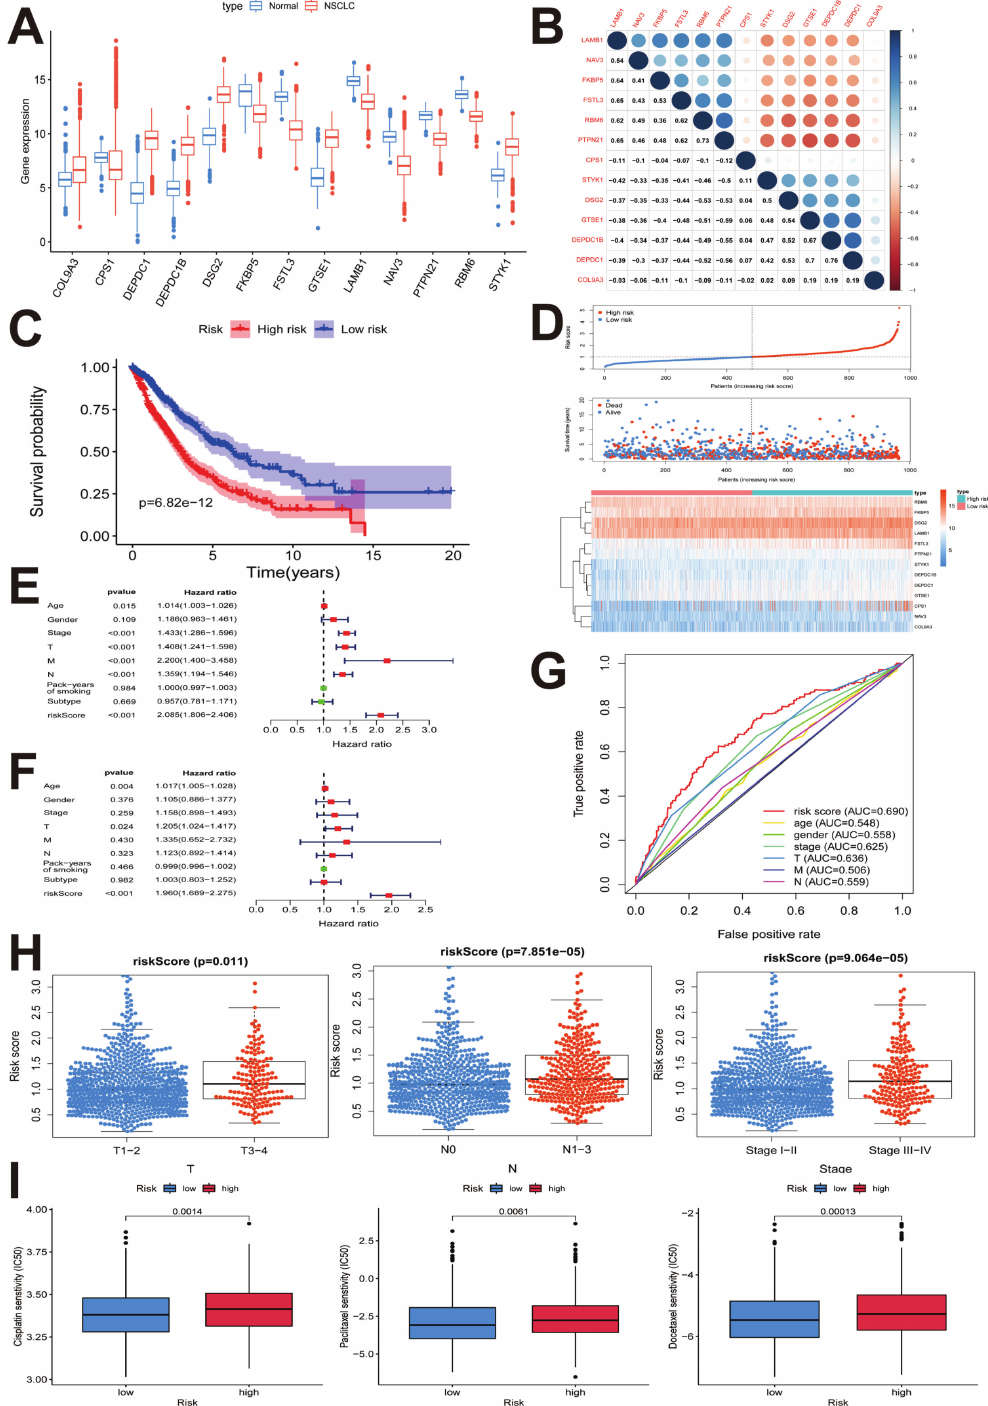
Fig 5. Construction of the 13-mRNA-based prognostic model to predict chemotherapeutic response. (A) Differential expression of 13 selected genes between NSCLC and normal samples. (B) Relationship of each gene in the 13 gene-based model. (C) Risk score distribution in patients with NSCLC, survival status in different groups, and heatmap of the expression of 13 genes. (D) K–M plot represents that patients in the high-risk group had significantly shorter OS than those in the low-risk group. (E) Forest plot of univariate Cox regression analysis showing the association between risk factors and NSCLC survival. (F) Forest plot of multivariate Cox regression analysis showing that the 13-mRNA signature was an